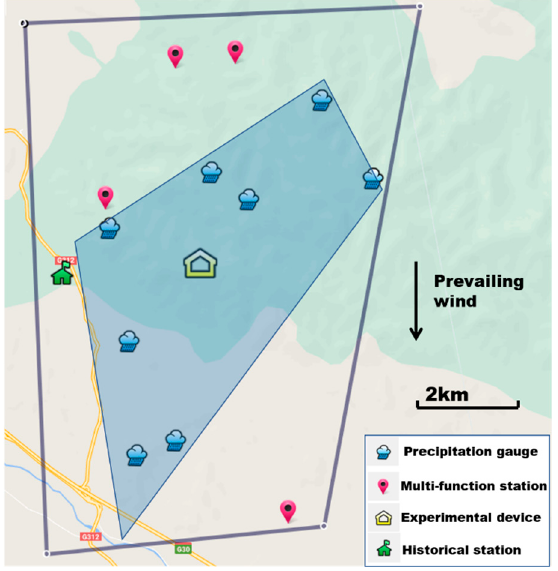
Figure 2. Satellite picture of Wushaoling area. Liupan Mountain ranges in northern China extending southward from Hui Autonomous Region of Ningxia across the eastern panhandle of Gansu province and into western Shanxi province, with a general elevation of 2000 m and individual peaks that reach 2995 m. The mountain is located on the northwestern edge of the southwest monsoon region, with southwest wind prevailing throughout the year. The area has an average of 133.7 days of precipitation and annual precipitation of 675.7 mm. The amount of cloud formation and water vapor is much higher than surrounding areas based on previous studies. The trend and extent of the convergence zone of the water vapor flux produced by the Liupan Mountain topography are consistent with that of the mountainous area. The dynamic effect of the low-level convergence and high-altitude divergence configuration in mountainous areas is conducive to the occurrence and development of precipitation. There is still considerable development space for precipitation enhancement. Three sites are located in Liupan Mountain, centered on a local meteorological station. The distances between the three sites are relatively close, while they are all constructed on different tuyeres, so that the catalytic effect of charged particles is expected to be more obvious. A satellite map of the Liupan Mountain area is shown in Figure 3, with the experimental devices and precipitation gauges labeled.